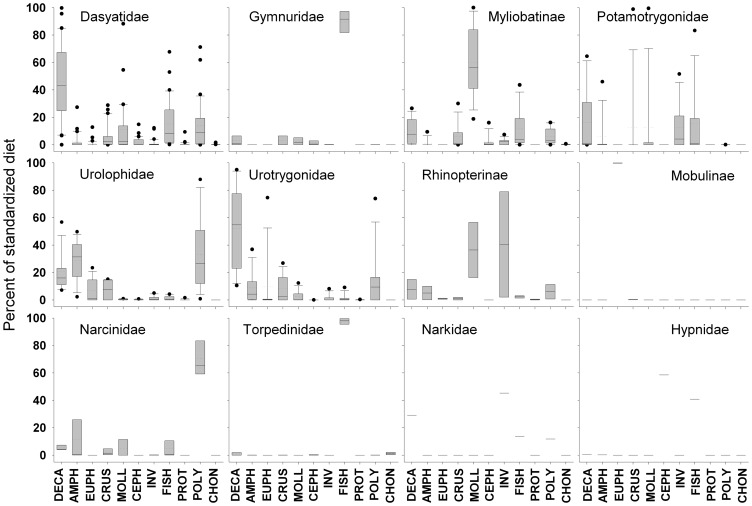
Prey category contributions to the standardised diets of each of the respective families and sub-families.Box plot represents the median standardised diet percentage (central line) and 25th and 75th percentiles; bars represent 10th and 90th percentiles; closed circles 5th and 95th Percentiles.